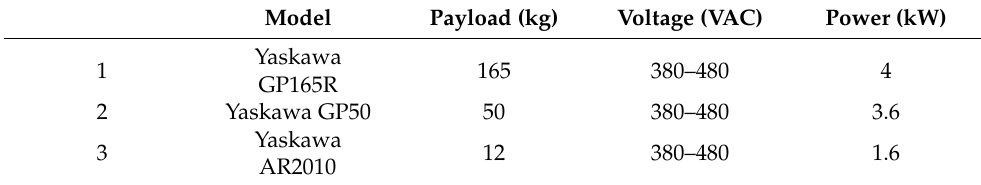
Table 22. Robots’ main features necessary for the CF calculation [74].